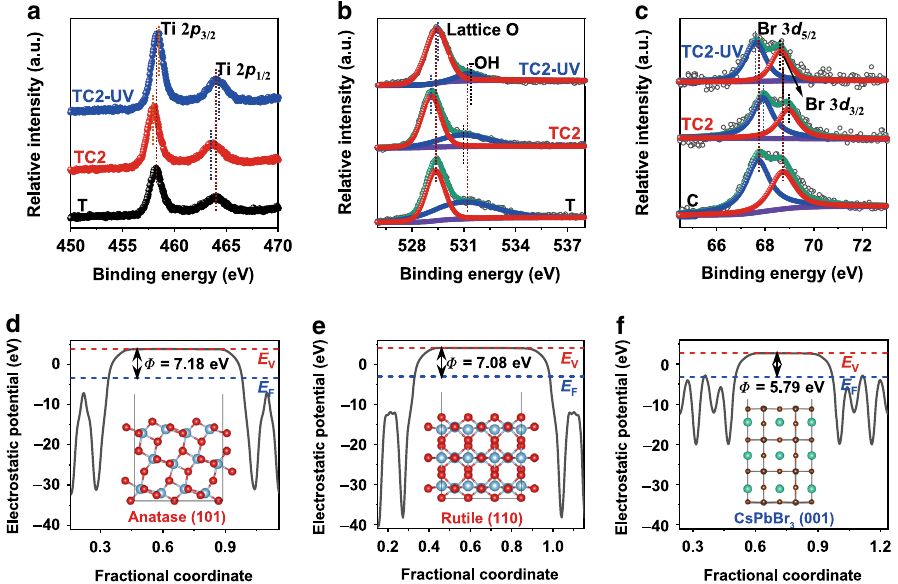
Fig. 3 Electron transfer between TiO 2 and CsPbBr 3 quantum dots (QDs). In-situ and ex-situ X-ray photoelectron spectroscopy (XPS) spectra of a Ti 2 p , b O 1 s , and c Br 3 d of TiO 2 , CsPbBr 3 , and TC2. In-situ XPS spectra were collected under UV – vis light irradiation. The electrostatic potentials of d anatase TiO 2 (101), e rutile TiO 2 (110), and f CsPbBr 3 (001) facets. The blue, red, green, gray, and brown spheres stand for Ti, O, Cs, Pb, and Br atoms, respectively. Blue and red dashed lines indicate the Fermi and vacuum energy